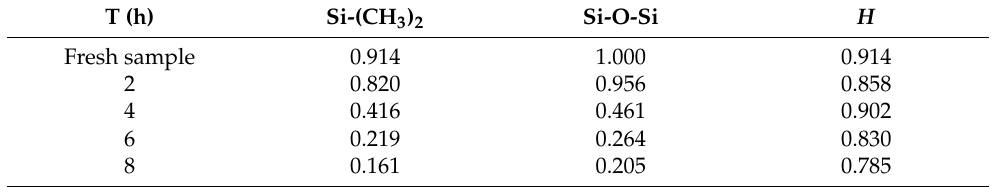
Table 7. The absorption peak height ratio of Si-O-Si and Si(CH 3 ) 2 (AC 3.6 kV, γ 20 = 1000 µ S/cm). T (h)